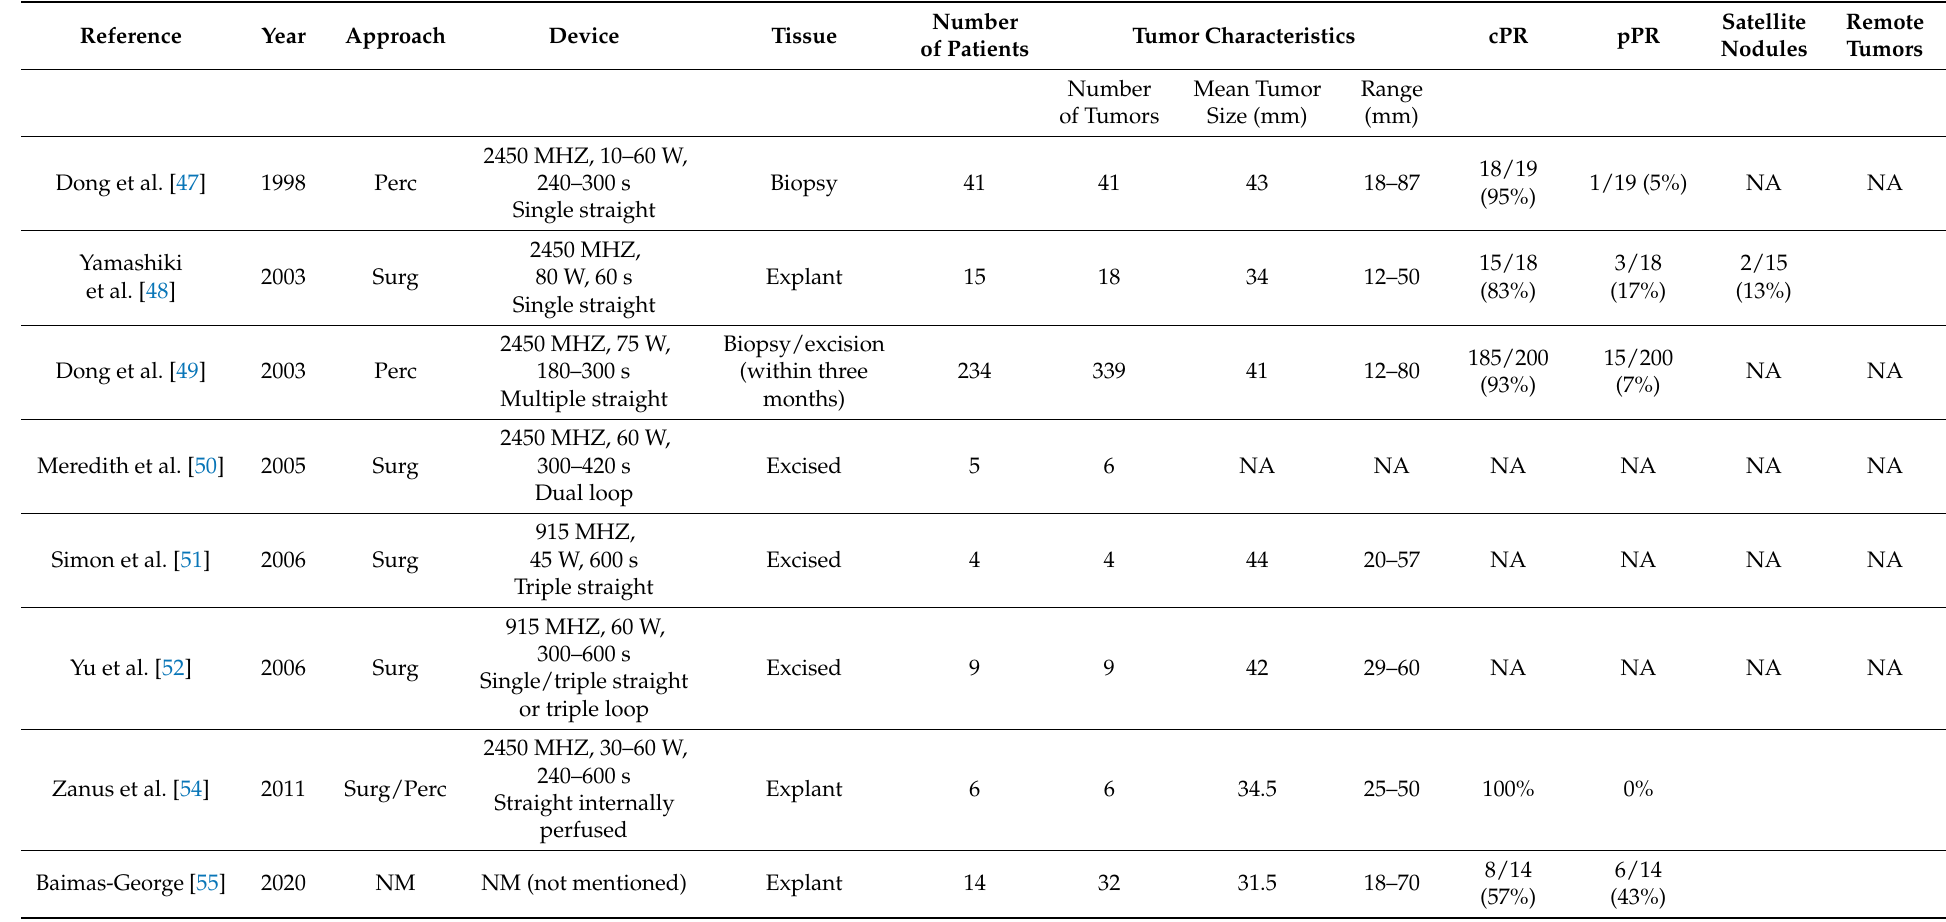
Table 2. Comparison of the rate of complete response following microwave ablation (MWA) for the local control of HCC based on histopathological evaluation of the excised tumors or liver explants at the time of